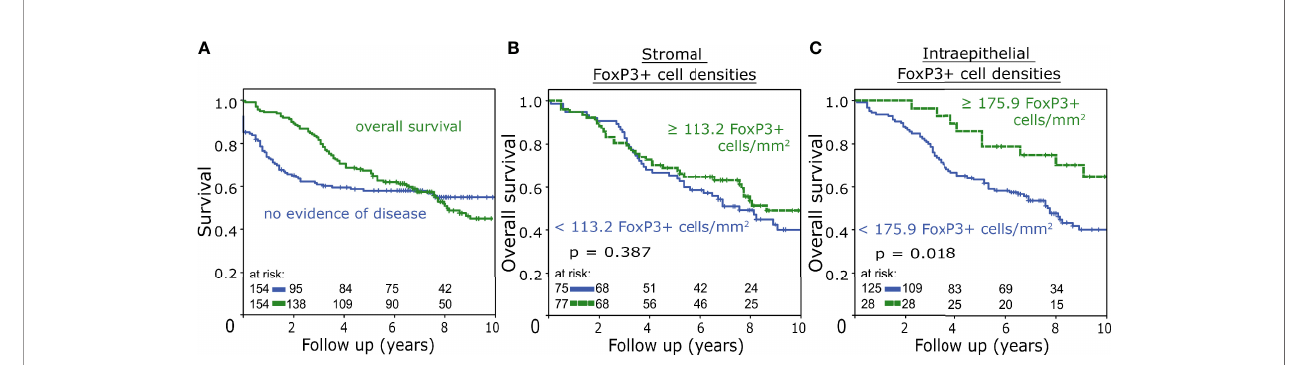
FIGURE 2 | (A) Overall survival and no-evidence-of-disease survival rate of the studied patient cohort analysed with the Kaplan-Meier method and log-rank test. (B, C) Overall survival analysed with the Kaplan-Meier method and log-rank test according to FoxP3+ tumour-in fi ltrating T cell densities in the stromal (B) and intraepithelial